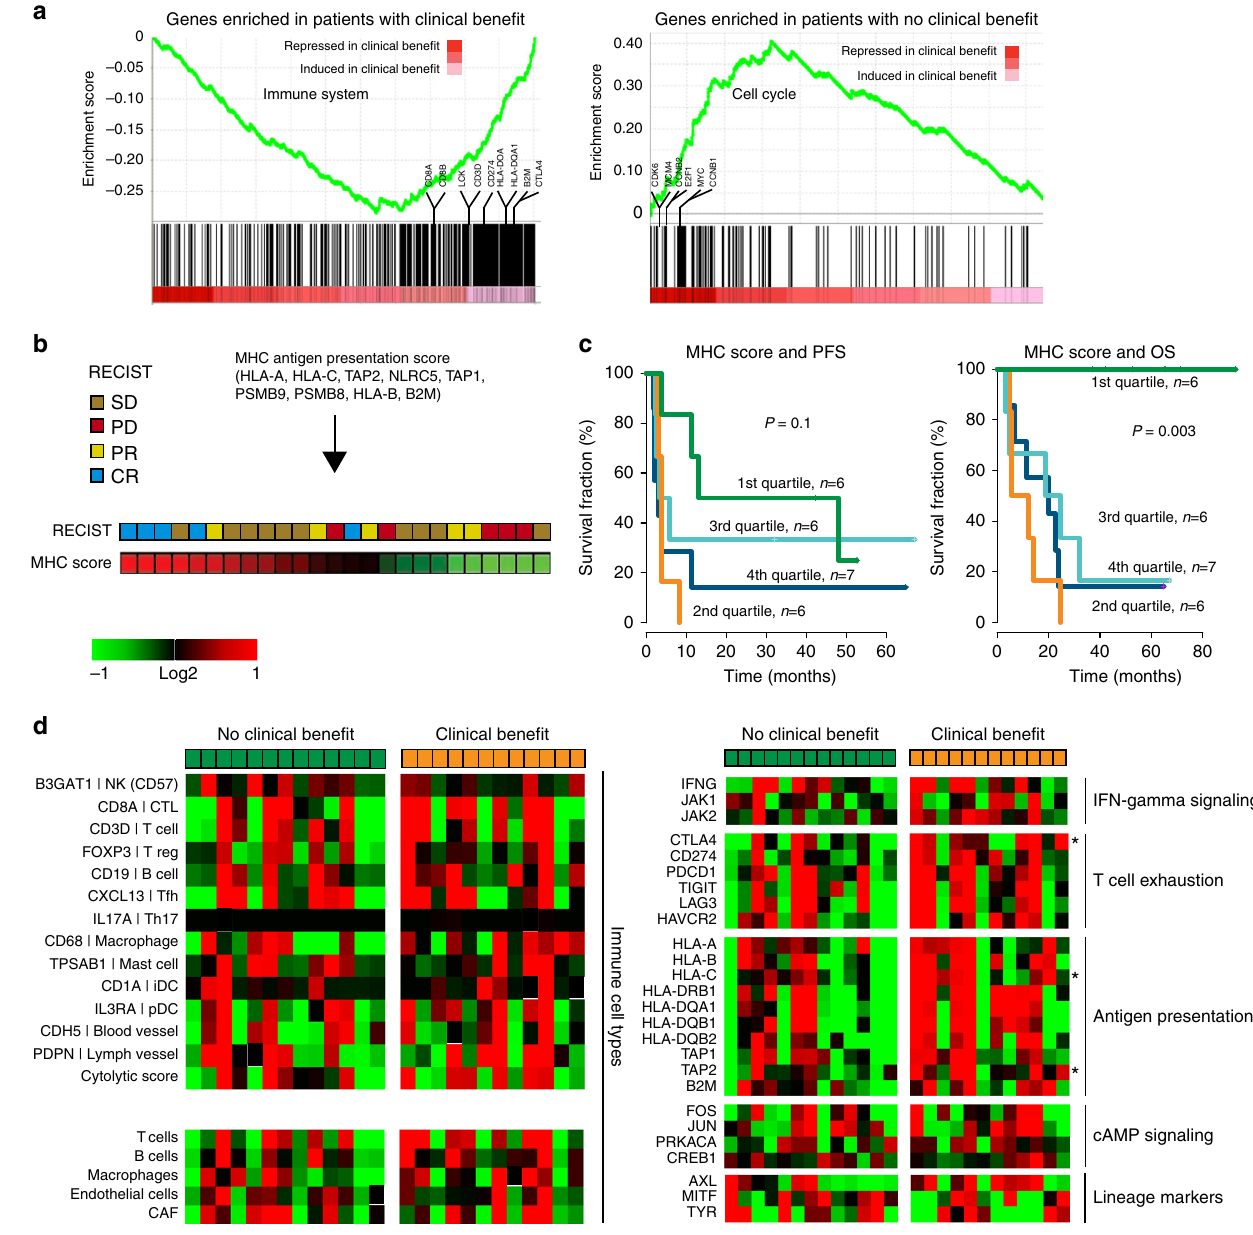
Fig. 4 Expression of immune related genes and association to bene fi t from ACT in melanoma. a Enrichment plots from gene set enrichment analysis for the immune system and cell cycle pathways. b MHC class I expression score was constructed from indicated genes. c Progression-free and overall survival by MHC score quartile. P -values from Cox regression. d Expression of immune response related and melanoma lineage genes in patients with no clinical bene fi t (green) and with clinical bene fi t (orange). Signatures in the lower left panel (T and B cells, Macrophages, Endothelial cells, and CAF) are derived from publication by Tirosh et al. 28 . Star denotes genes with signi fi cant association to bene fi t from ACT ( P < 0.05, t